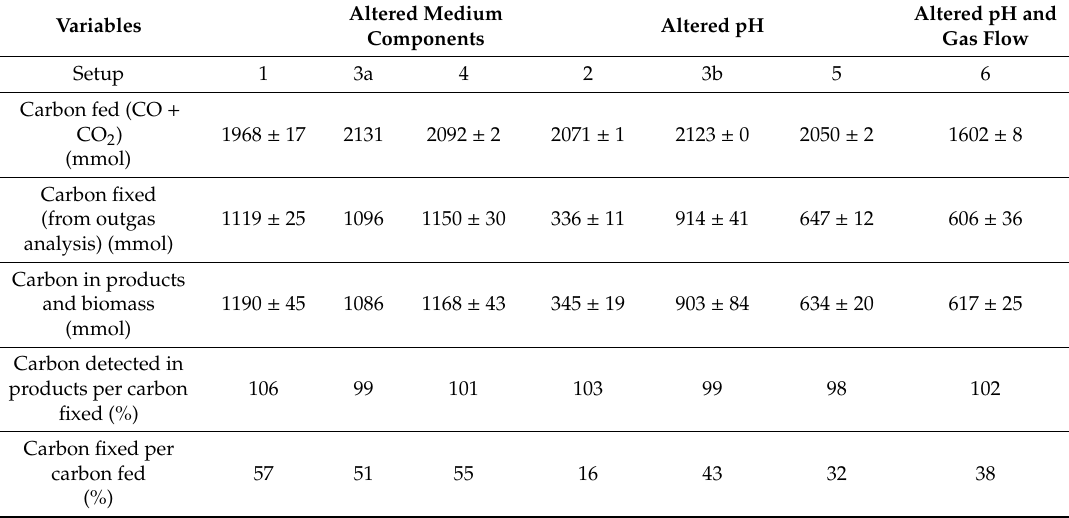
Table 5. Carbon balance for each entire run. The amount of carbon fed (the sum of the carbon content in mmol, for both carbon monoxide and carbon dioxide), the amount of carbon fixed, derived from the calculation based on the outgas analysis (the di ff erence between the amount fed and the amount detected in the outgas, in mmol), and the amount of carbon detected in the measured products and biomass (in mmol) are shown here. The values given are the average of a triplicate ( n = 3), with standard deviations, except for Setup 3a, which is calculated for the fermenter where pH was not altered, and Setup 3b, which refers to the pair of fermenters where the pH was changed after 68 h to 5.4. Altered pH and Altered Medium Altered pH Variables Gas Components